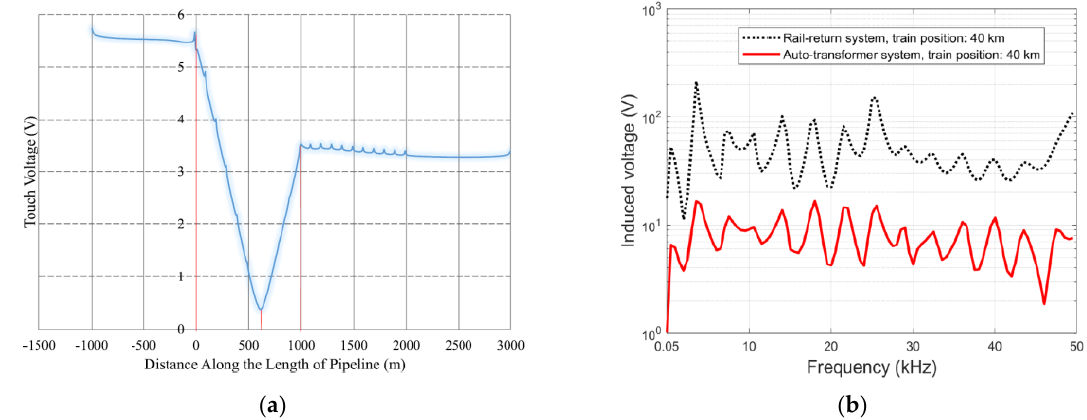
Figure 23. The induced and touch voltage on a conductor parallel to ERPS track. ( a ) Induced voltage based on the distance of the conductor [ 131 ]. ( b ) Induced voltage based on frequency for both 1 × 25 kV and 2 × 25 kV ERPSs [ 132 ].